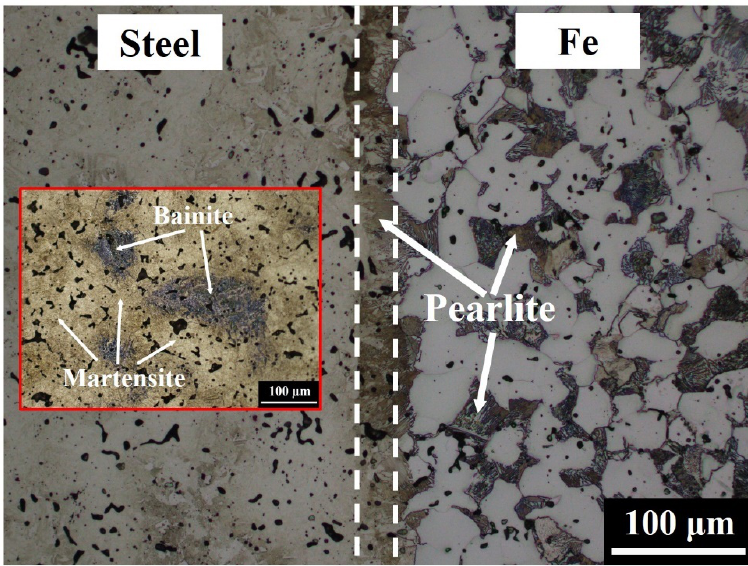
Figure 2. Microstructure at the interface of the Fe-4Ni-3Cr-0.5Mo-0.5C/Fe LMC.